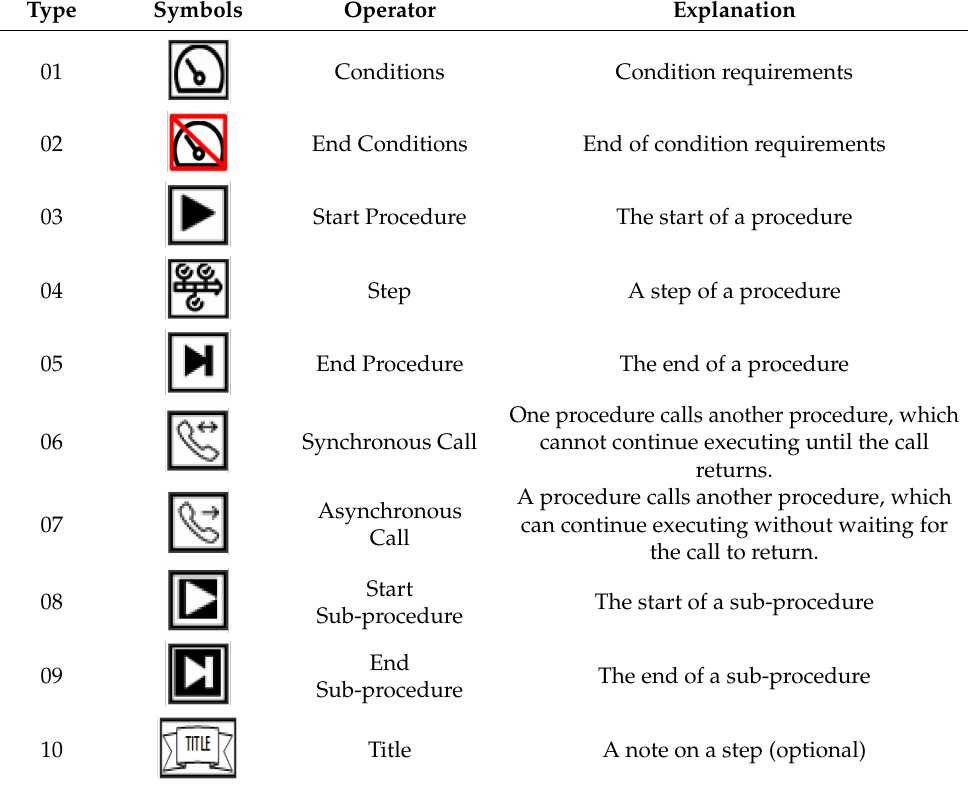
Table 1. Explanation of MSM